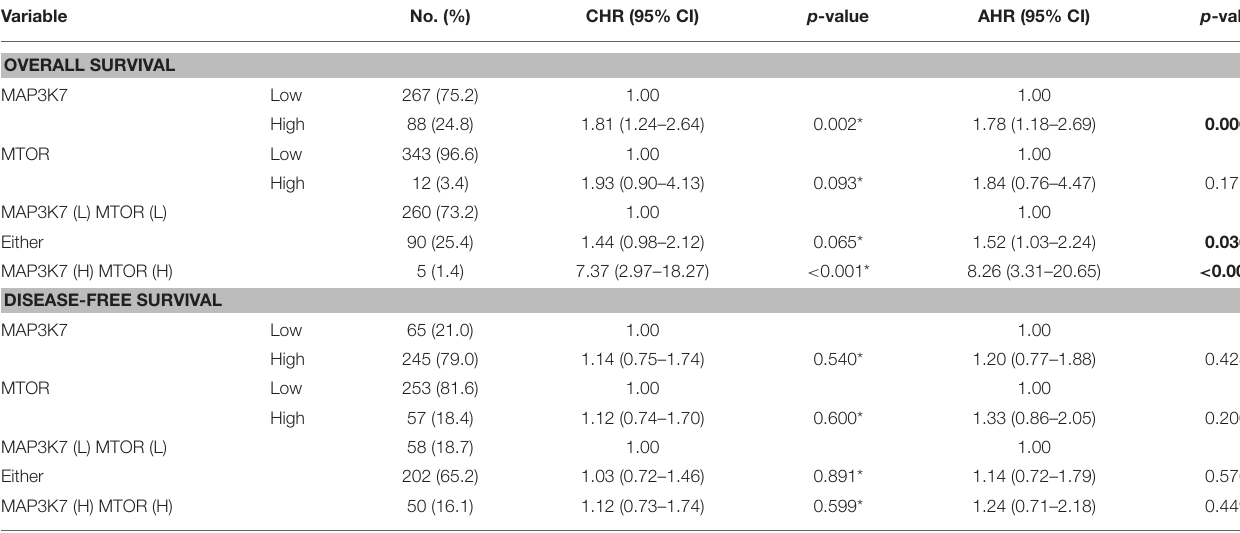
TABLE 1 | Co-expression of MAP3K7 and MTOR in overall survival and disease-free survival of HCC patients. Variable No. (%) CHR (95% CI) p -value AHR (95%